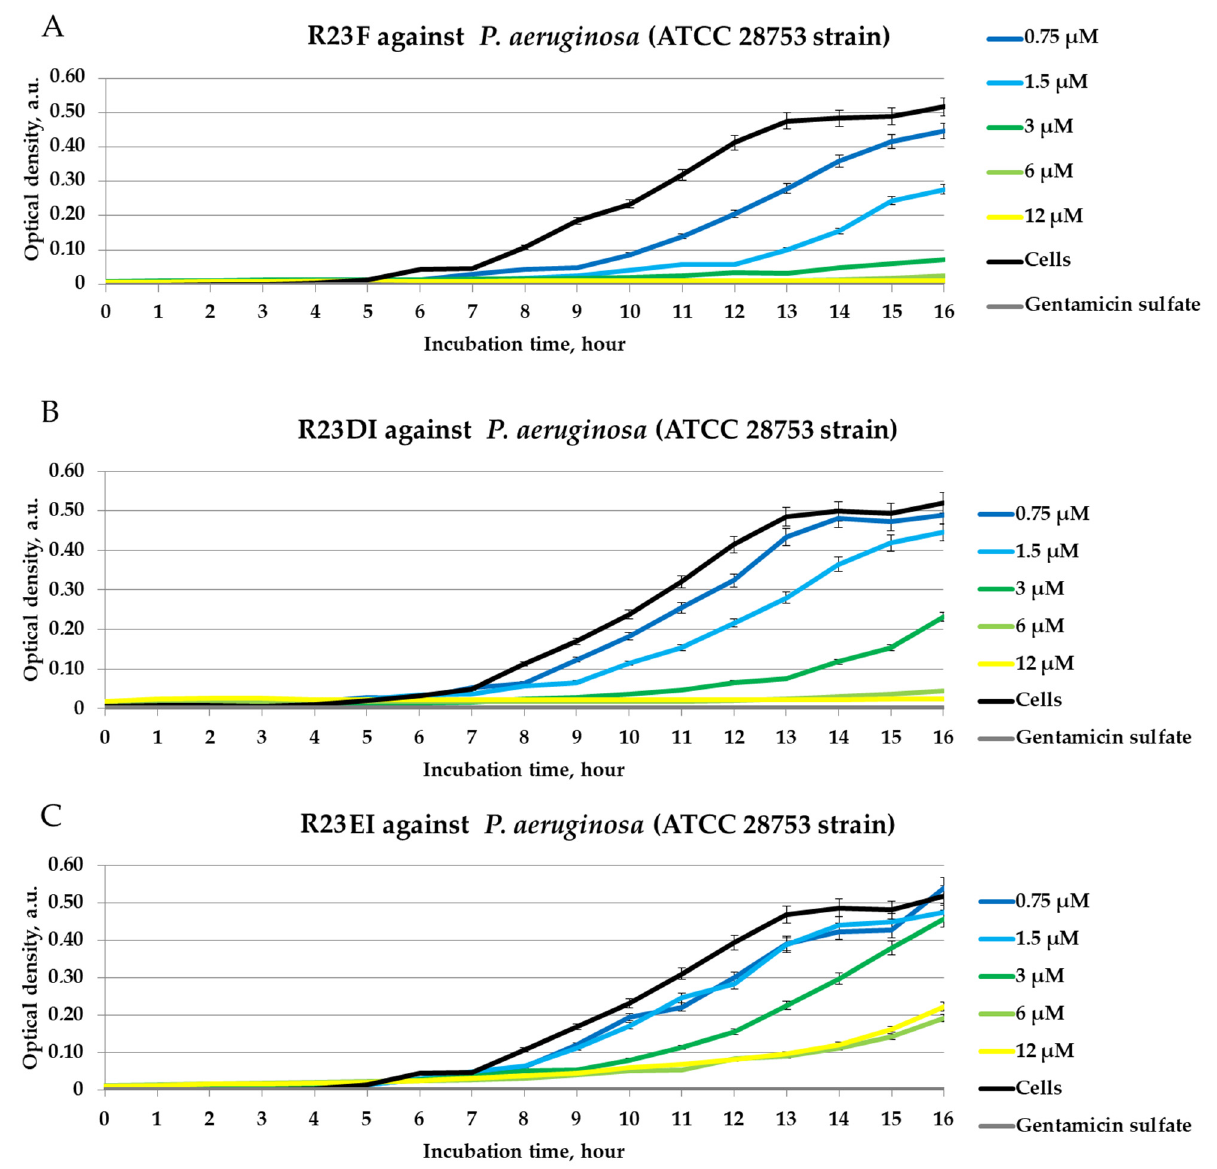
Figure 7. Inhibitory activity of peptides R23F ( A ), R23DI ( B ), R23EI ( C ) during 16 h of incubation with P. aeruginosa strain ATCC 28753 cells. A gentamicin sulfate concentration of 1700 µ M was used as a positive control of the antimicrobial effect. ATCC 28753 cells without peptide were used as negative controls. The experiments were performed in three replicates. The results were expressed as the mean ± standard deviation (M ± SD).